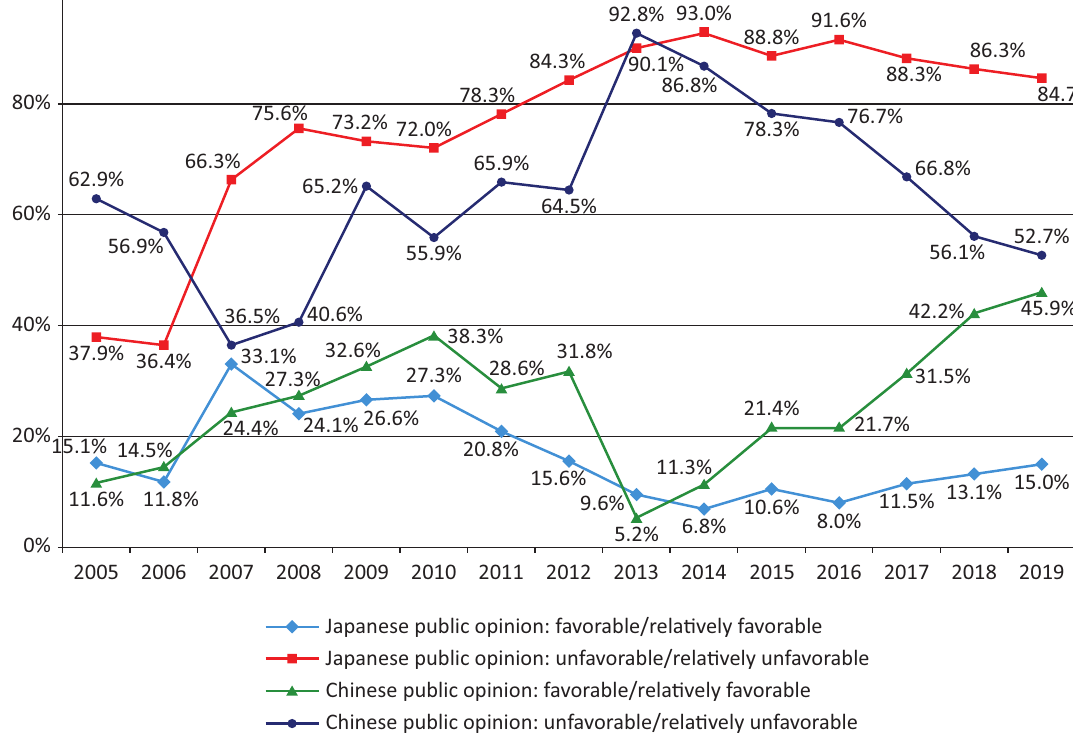
Figure 2. Genron NPO Japan–China Public Opinion Survey, 2005–2019. Source: The Genron NPO (2019). Media and Communication, 2021, Volume 9, Issue 3, Pages